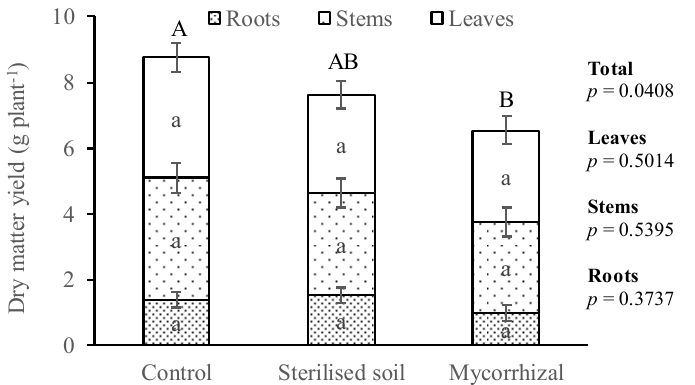
Figure 2. Dry matter yield of young plants separated by roots, stems, and leaves as a function of soil treatments. After ANOVA examination ( p . Prob. > F), within each plant part (lowercase letters) and total (uppercase letters) means ( n = 6) followed by the same letter are not significantly different by Tukey HSD test ( α = 0.05). Vertical bars are the standard errors.